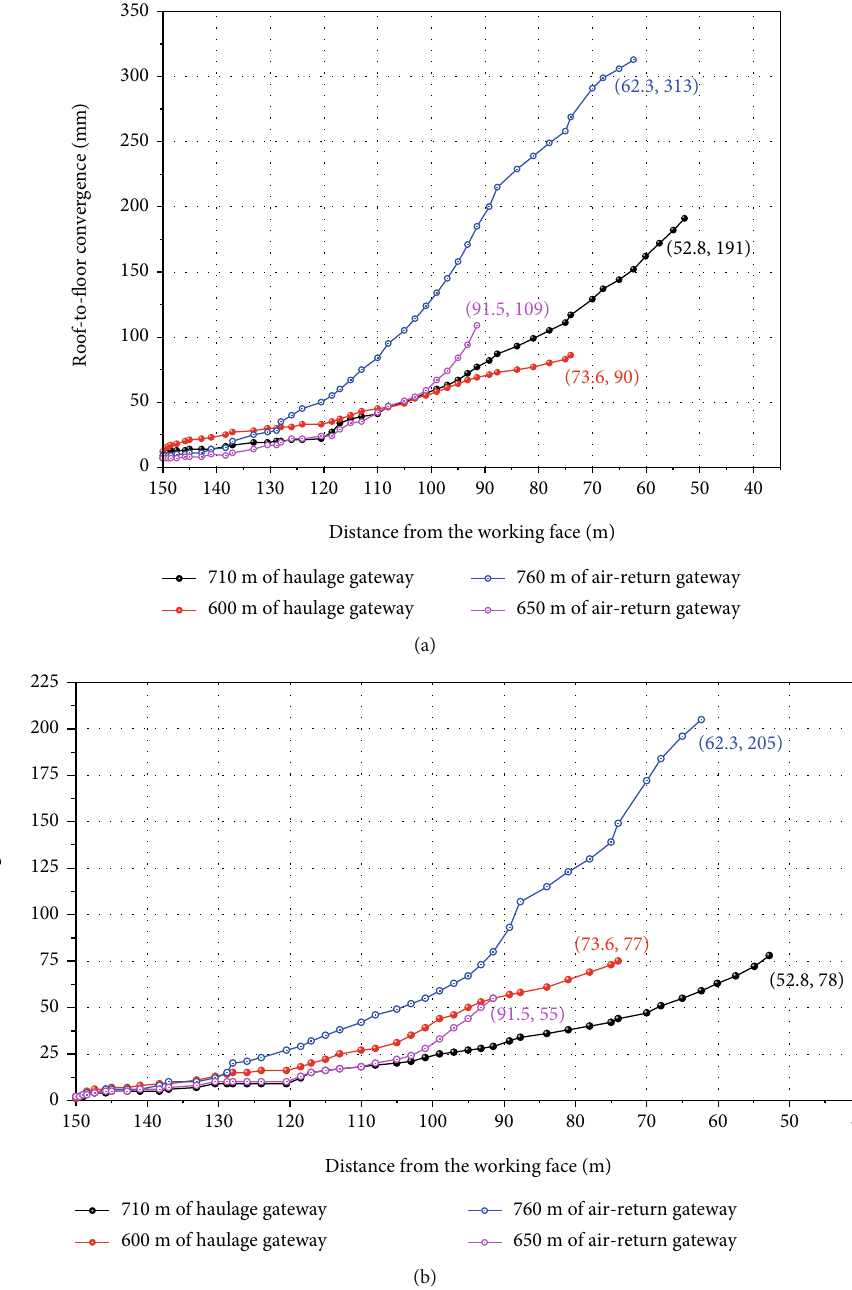
Figure 10: The gateway deformation. (a) The trend of the roof-to- fl oor convergence. (b) The trend of the horizontal convergence. Table 3: Comparison of parameters of 14141 and 14121 longwall